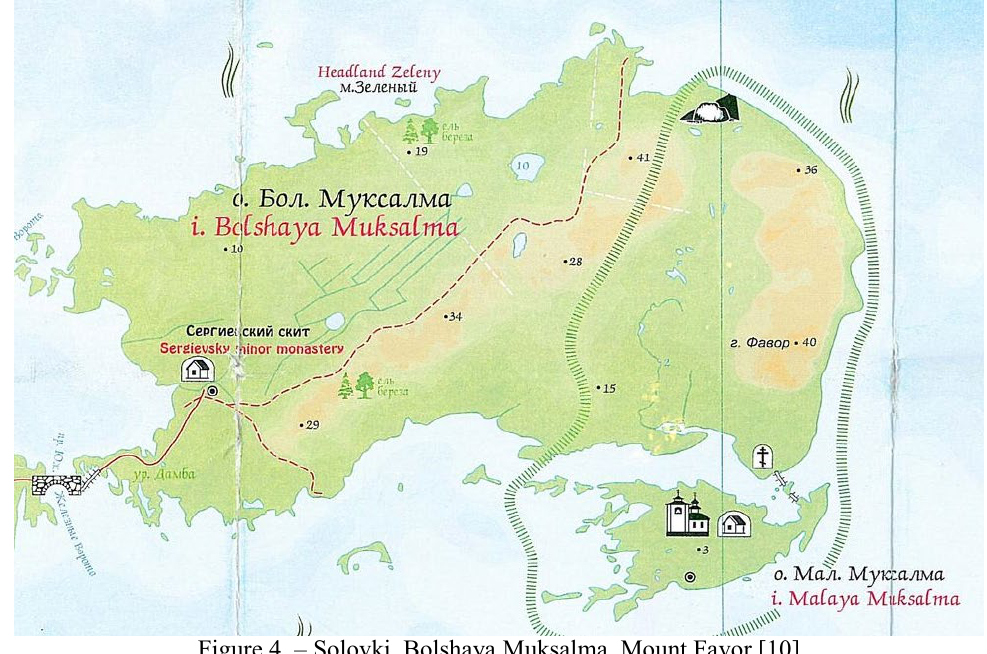
Figure 4. – Solovki. Bolshaya Muksalma. Mount Favor [10]